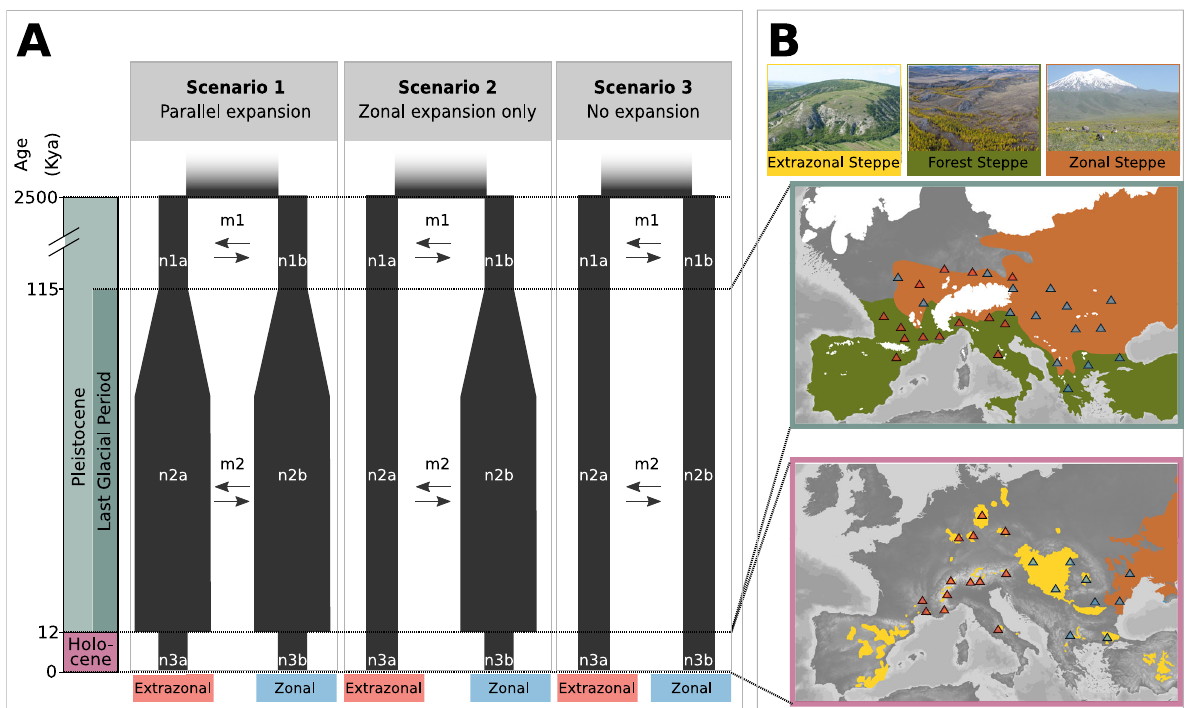
Fig. 1 Hypothetical scenarios for the demography of steppe biota in the light of late Quaternary steppe range dynamics. A Overview of the three demographic scenarios evaluated for the European steppe biota in relation to age and geological epoch (scaling not continuous). In Scenario 1, Parallel expansion, an increase in effective population size ( n ) in extrazonal and zonal steppe lineages during the last glacial period (LGP), followed by a contraction of n in the Holocene, is assumed. Scenario 2, Zonal expansion only, implies expansion and contraction for zonal steppe lineages, but a constant population size for extrazonal steppe lineages. Scenario 3, No expansion, involves no change in effective population size in neither extrazonal nor zonal lineages. All scenarios include bidirectional migration ( m ) between the extrazonal and zonal steppe lineages in the pre-LGP and LGP periods. B Vegetation in Europe under climatic conditions of the Last Glacial Maximum ~21,000 kya (upper map, modi fi ed from Anhuf et al. 77 ), and under present-day (that is, warm stage) conditions (modi fi ed from Kirschner et al. 19 ; Wesche et al. 10 ) brown areas represent zonal steppe (i.e., macroclimatically induced continuous steppe), yellow areas represent extrazonal steppes (patchy steppe occurrences embedded in a matrix of the forest), green areas represent forest steppe (open forest with an understory of steppe biota), and white areas show glaciated areas 78 . Blue and red triangles show hypothetical occurrences of populations of steppe species pertaining to extrazonal and zonal lineages,